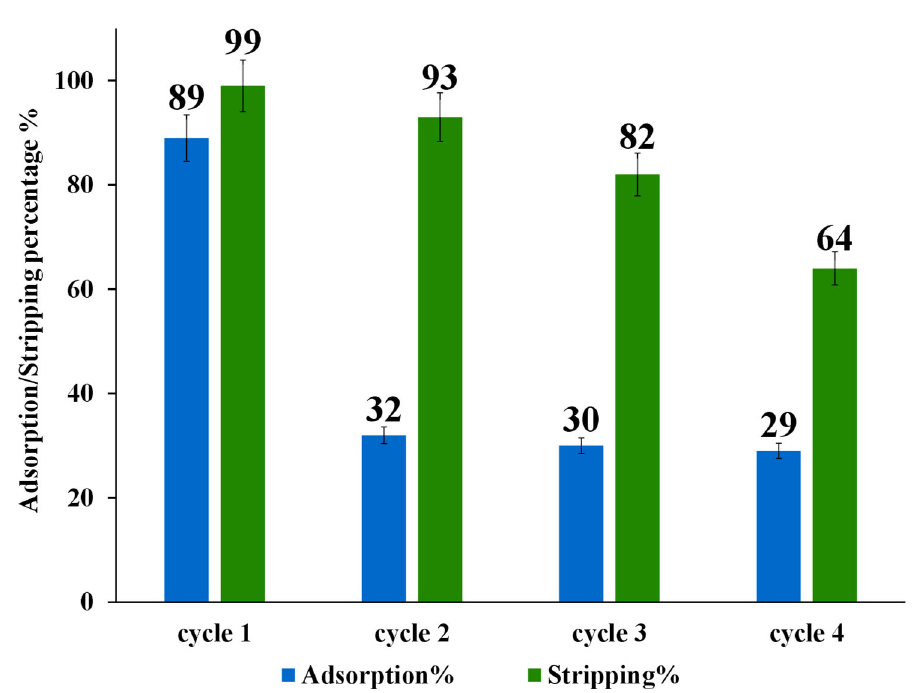
Figure 7. Adsorption and stripping cycles of 10 ppm Au(III) on ZrO 2 -L 6 .